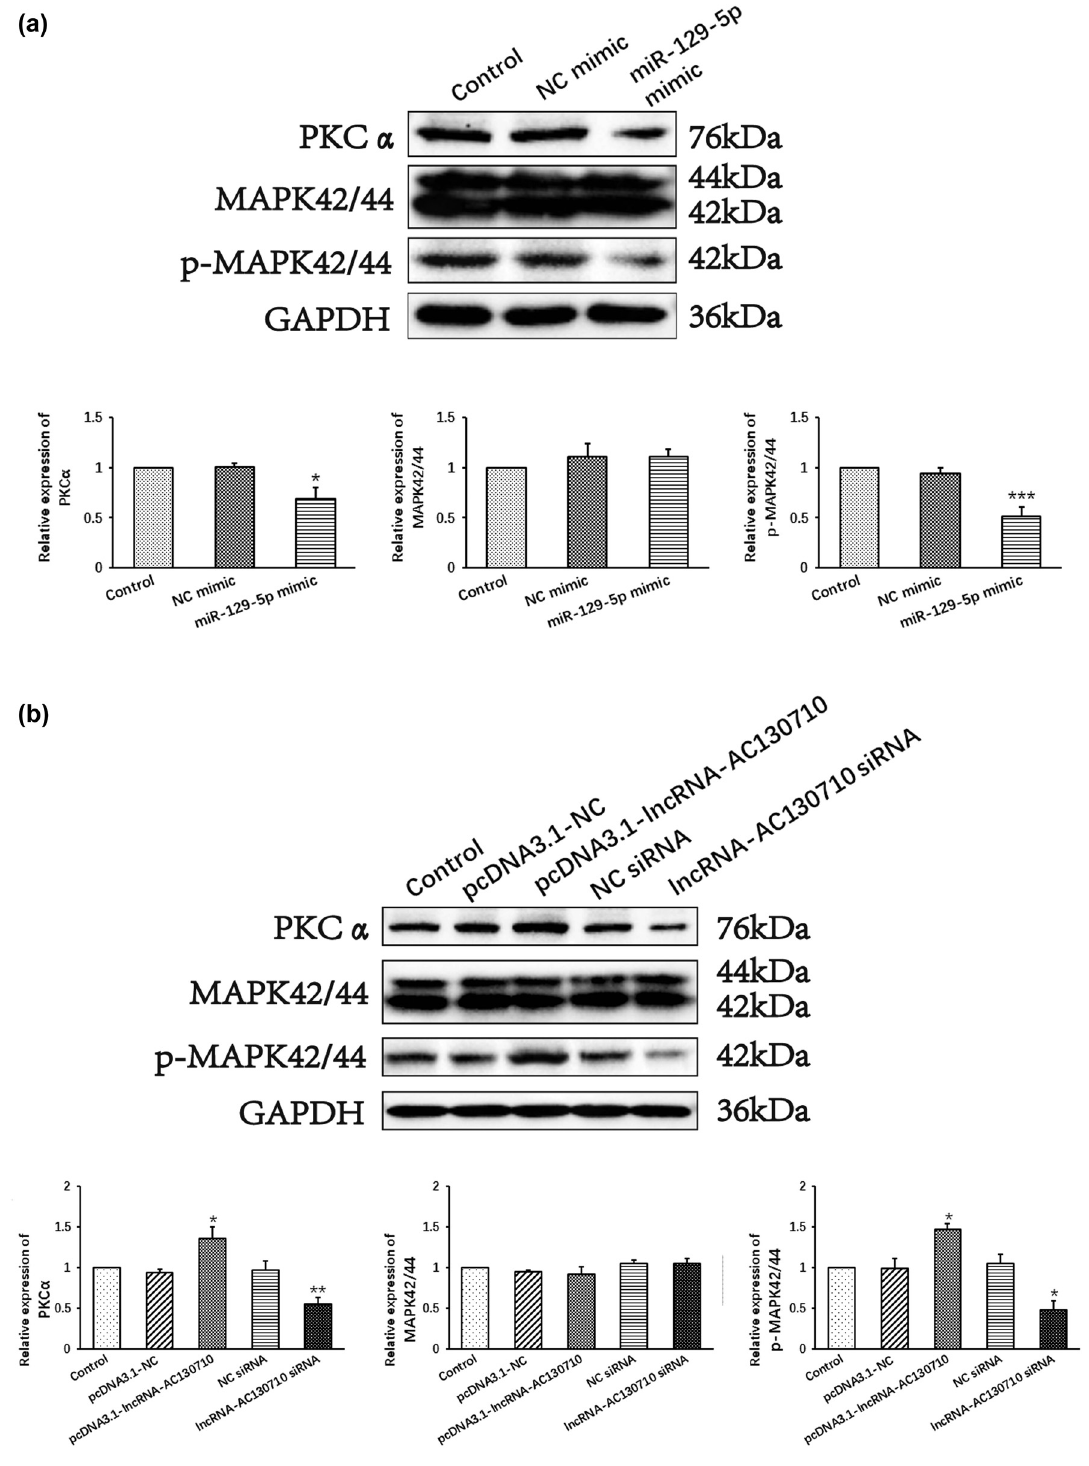
Figure 6: E ff ect of miR - 129 - 5p and lncRNA - AC130710 on PKC α - MAPK signal pathway. ( a ) E ff ect of miR - 129 - 5p overexpression on PKC α - MAPK signal pathway in A375 cells. ( b ) E ff ect of lncRNA - AC130710 overexpression and lncRNA - AC130710 silencing on PKC α - MAPK signal pathway in A375 cells. Data are presented as means ± SD ( n = 3; * p < 0.05, ** p < 0.01, *** p < 0.001 )